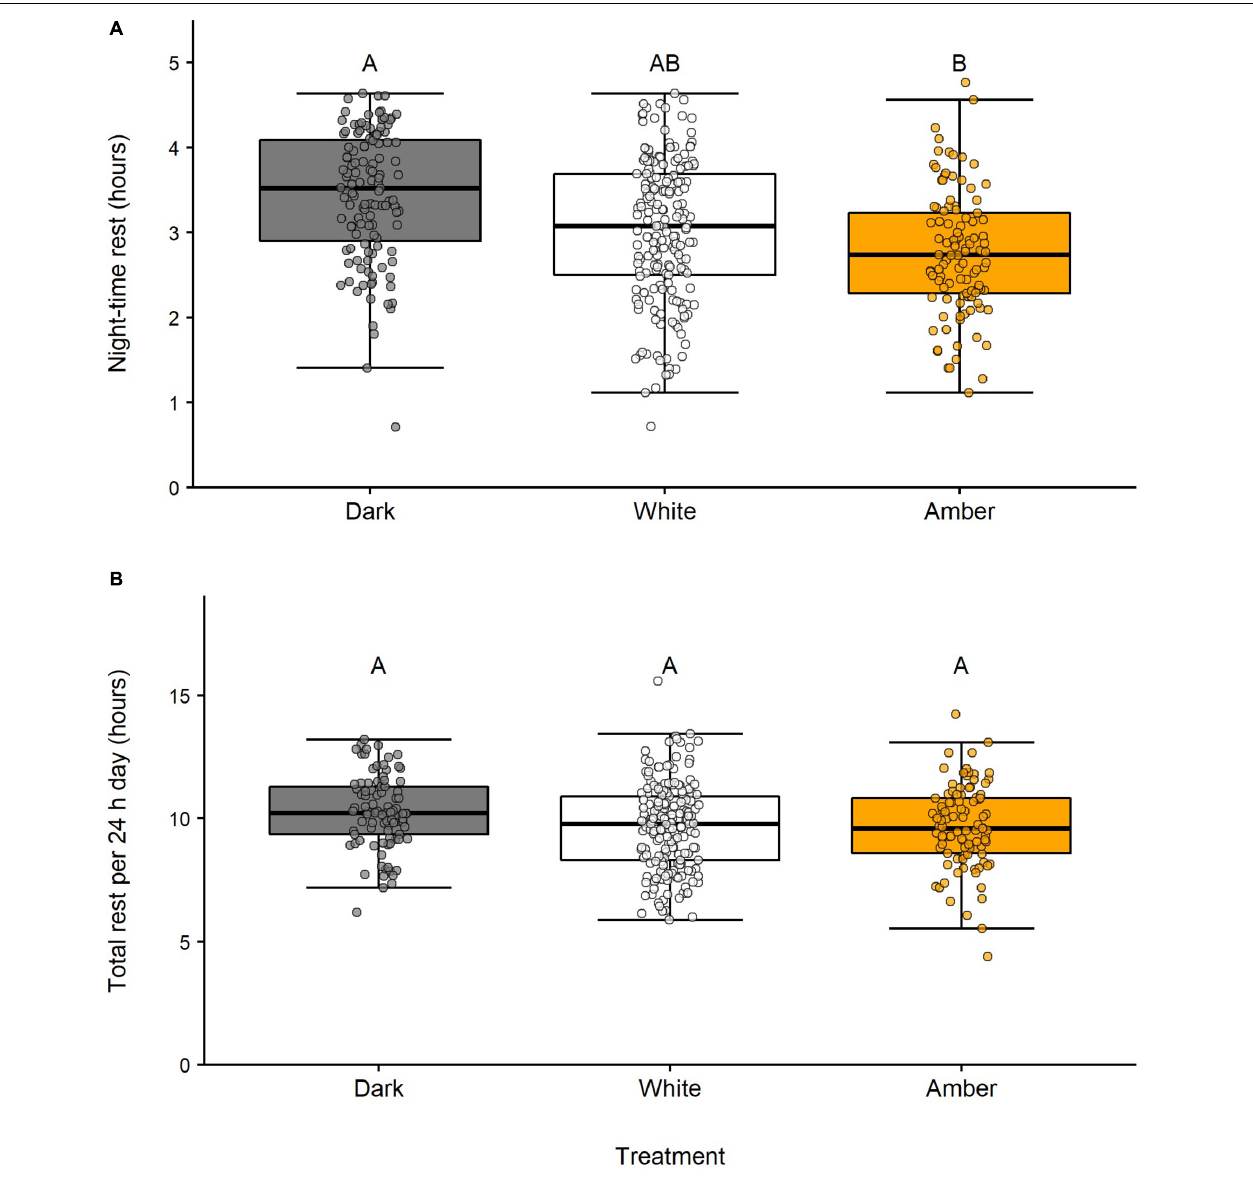
FIGURE 2 | Effects of streetlighting at night on (A) time swans spent resting during astronomical night and (B) total rest over 24 h days. Different letters denote significant differences between treatments; treatments with no letters in common were significantly different to each other ( p < 0.05). Boxplots are Tukey boxplots showing median values (horizontal lines), interquartile ranges (IQR; boxes), and ranges excluding outliers (whiskers; outliers defined as values more than 1.5 × IQR beyond box edges). Individual points represent data for each swan ( n = 11) on each day/night, including outliers (total observations: dark a = 123, dark b = 93, white a = 185, white b = 185, amber a = 109, amber b = 96). Differences in the numbers of observations were due to exclusion of data after handling swans, loss of data loggers, and temporary removal of data loggers from individuals due to abrasion of